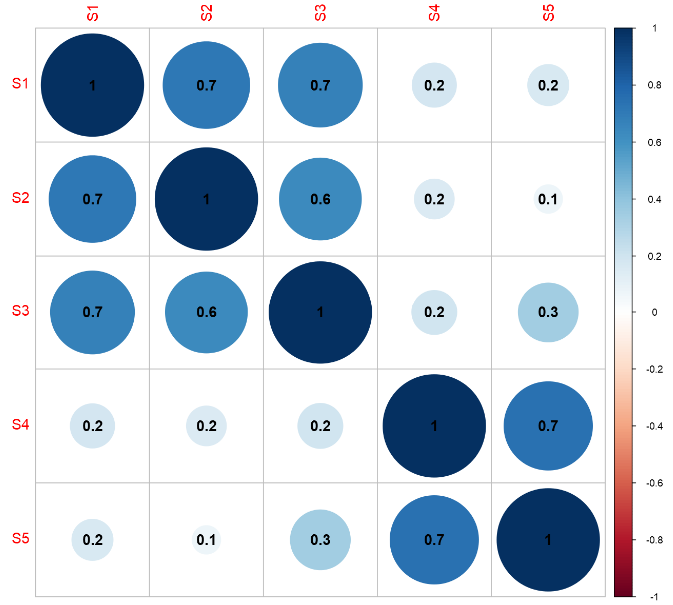
Figure 4. Matrix of correlation of energy consumption in technological processes for cauliflower processing.